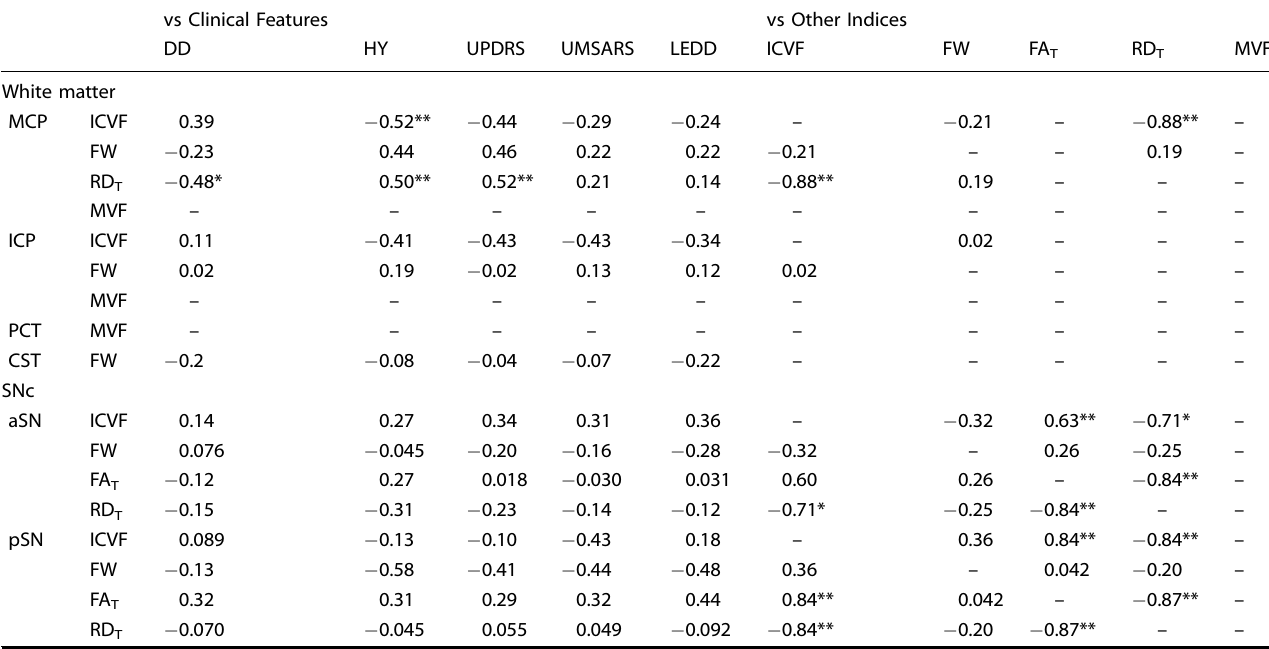
Table 3. Spearman rank correlation results between regions showing signi fi cant differences in the ROI analysis and clinical features or MRI indices in the second